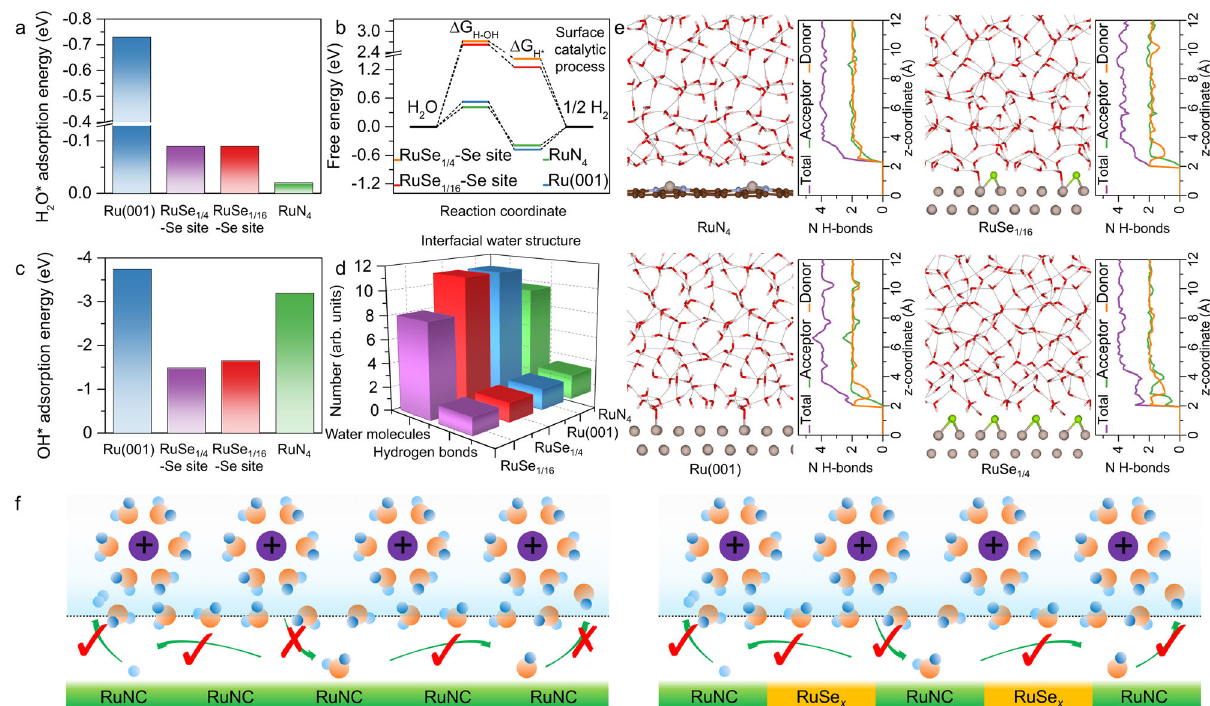
Fig. 1 | Theoretical simulation. a The adsorption energies of water molecule for different models. b The free energy changes of water dissociation and the Gibbs free energies of hydrogen adsorption for different models. c The adsorption energies of hydroxide for different models. d The average number of hydrogen bonds per interfacial water molecule and the corresponding number of water